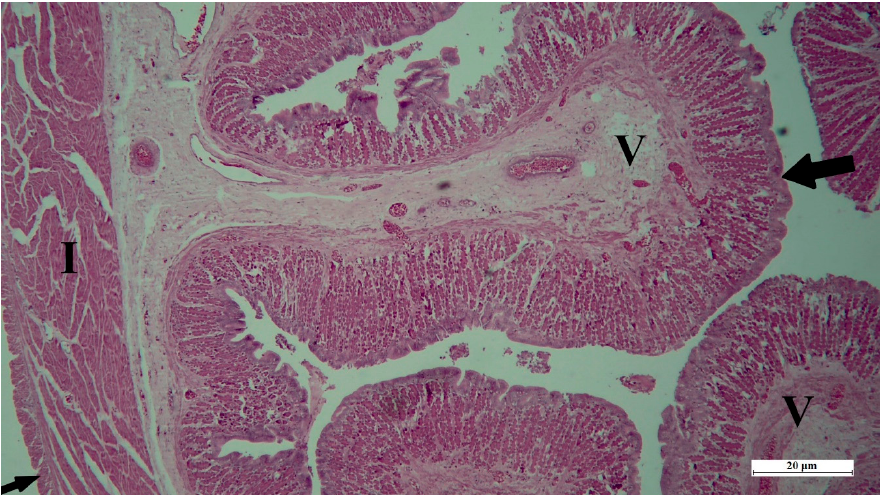
Figure 5. Transverse section photomicrographs of the intestine in N. Nandus (V = villi of the intestine, I = inner circular muscle, small arrow = tunica serosa, large arrow = epithelium).